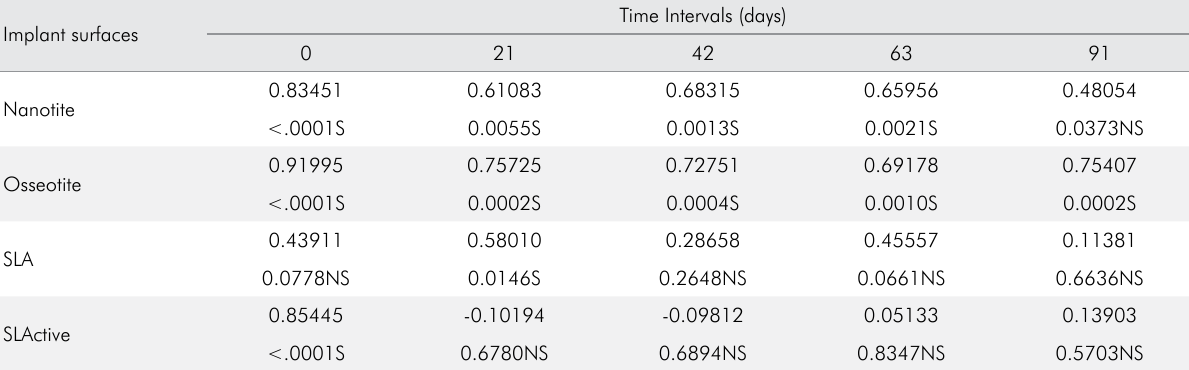
Table 2. Correlation between IT and ISQ in the critical time points. Implant